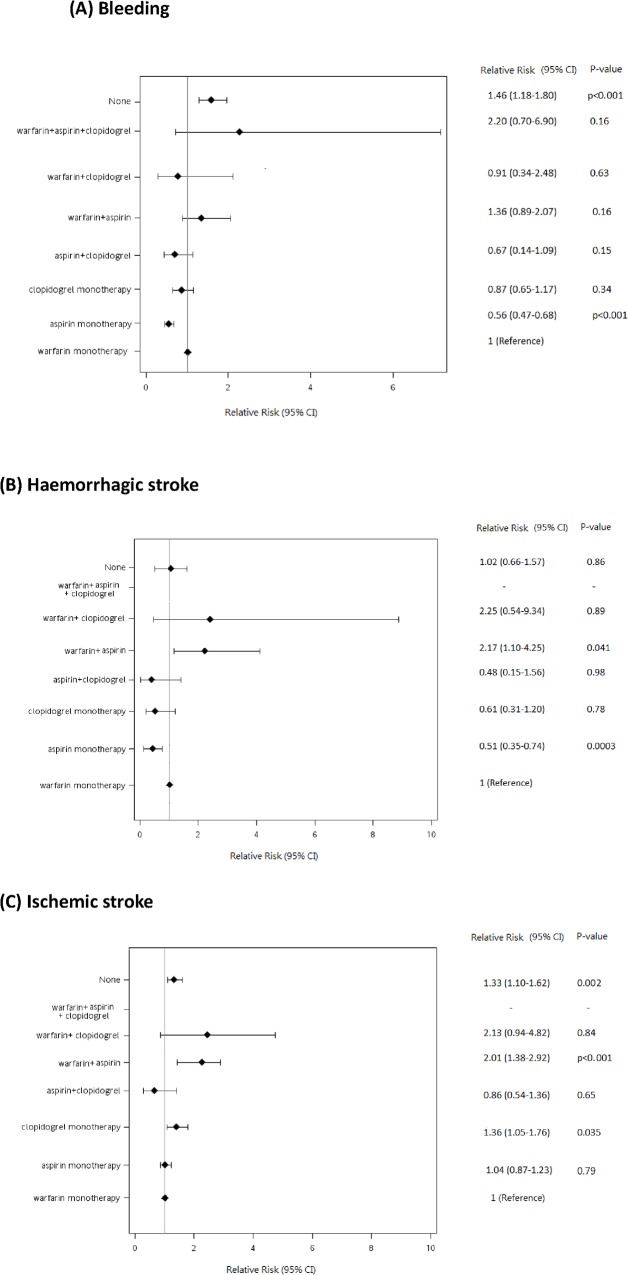
Relative risks for the risk of bleeding (A), hemorrhagic stroke (B), and ischemic stroke (C), associated with the use of warfarin, aspirin, clopidogrel, and combinations of these drugs in the study patients.CI indicates confidence interval.